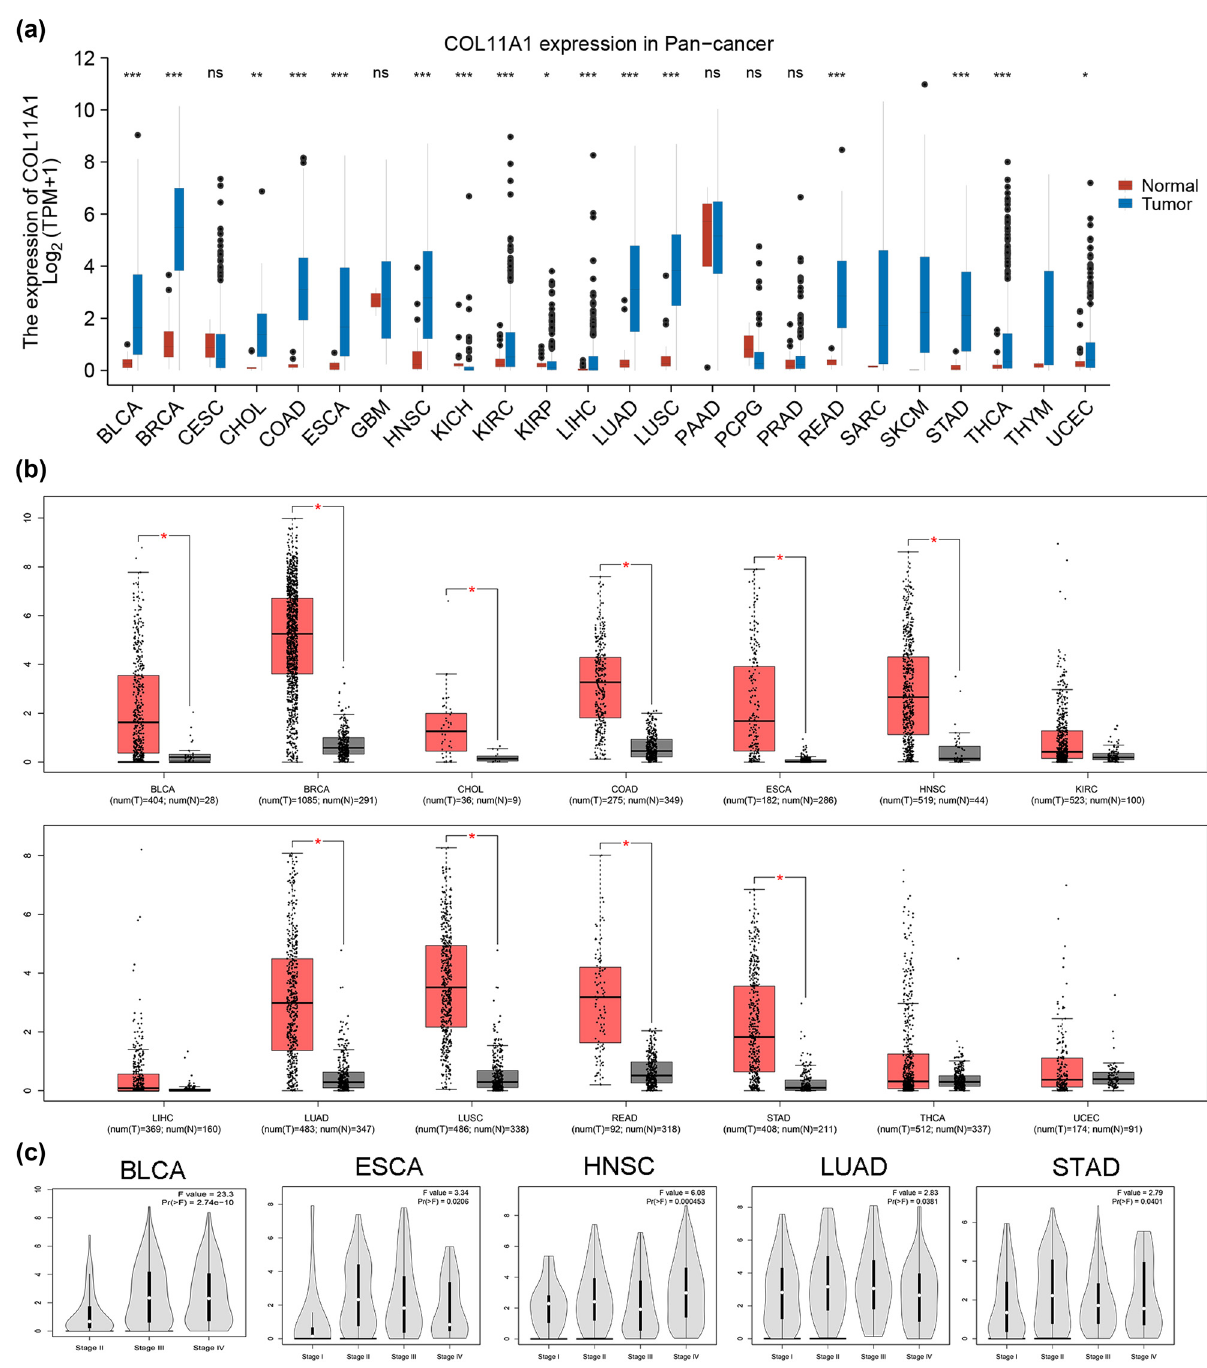
Figure 1: COL11A1 expression in Pan - cancer. COL11A1 expression in 24 cancer types was evaluated using the TCGA database ( a ) . GEPIA database was utilized to validate COL11A1 expression in 14 cancer types ( b ) . GEPIA database for the detection of COL11A1 in BLCA, ESCA, HNSC, LUAD and STAD with di ff erent stages ( c ) . * P < 0.05, ** P < 0.01 and *** P < 0.001 compared with the control